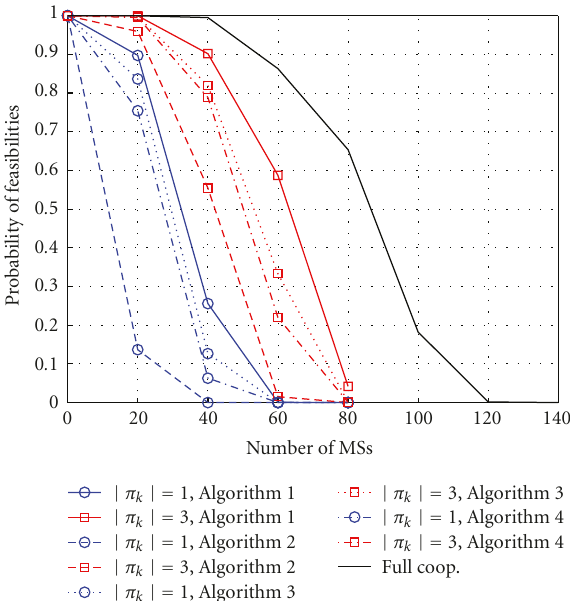
Figure 3: Comparison of probabilities of feasibility versus the number of MSs with the SINR constraint of 8dB.